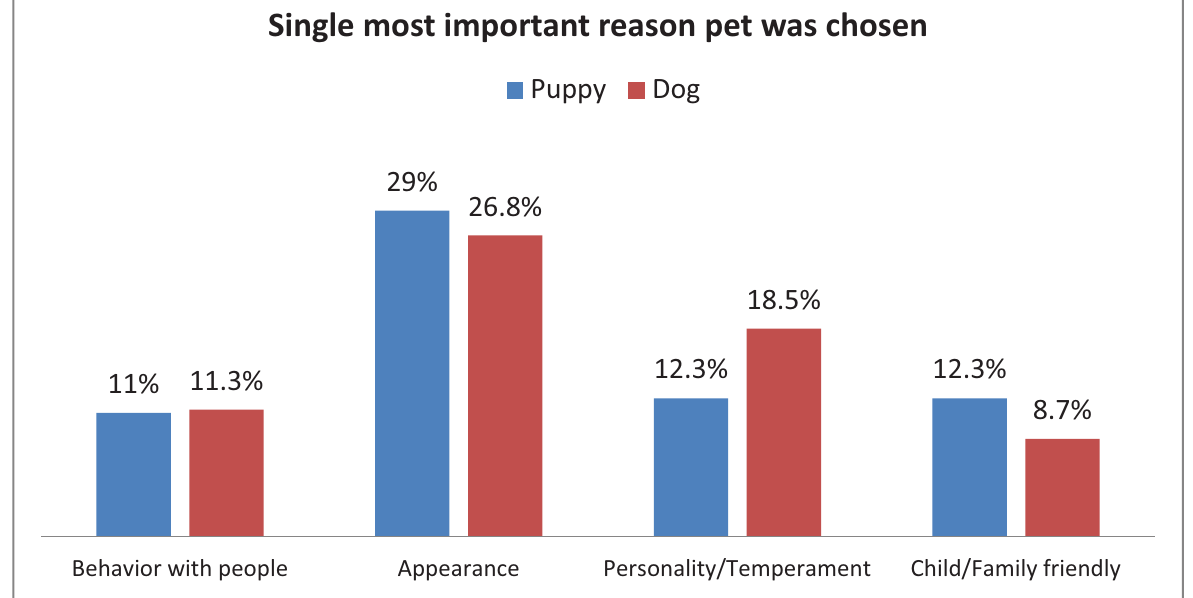
Figure 4. Adopter’s responses when asked the most important reason they choose their puppy or adult dog.